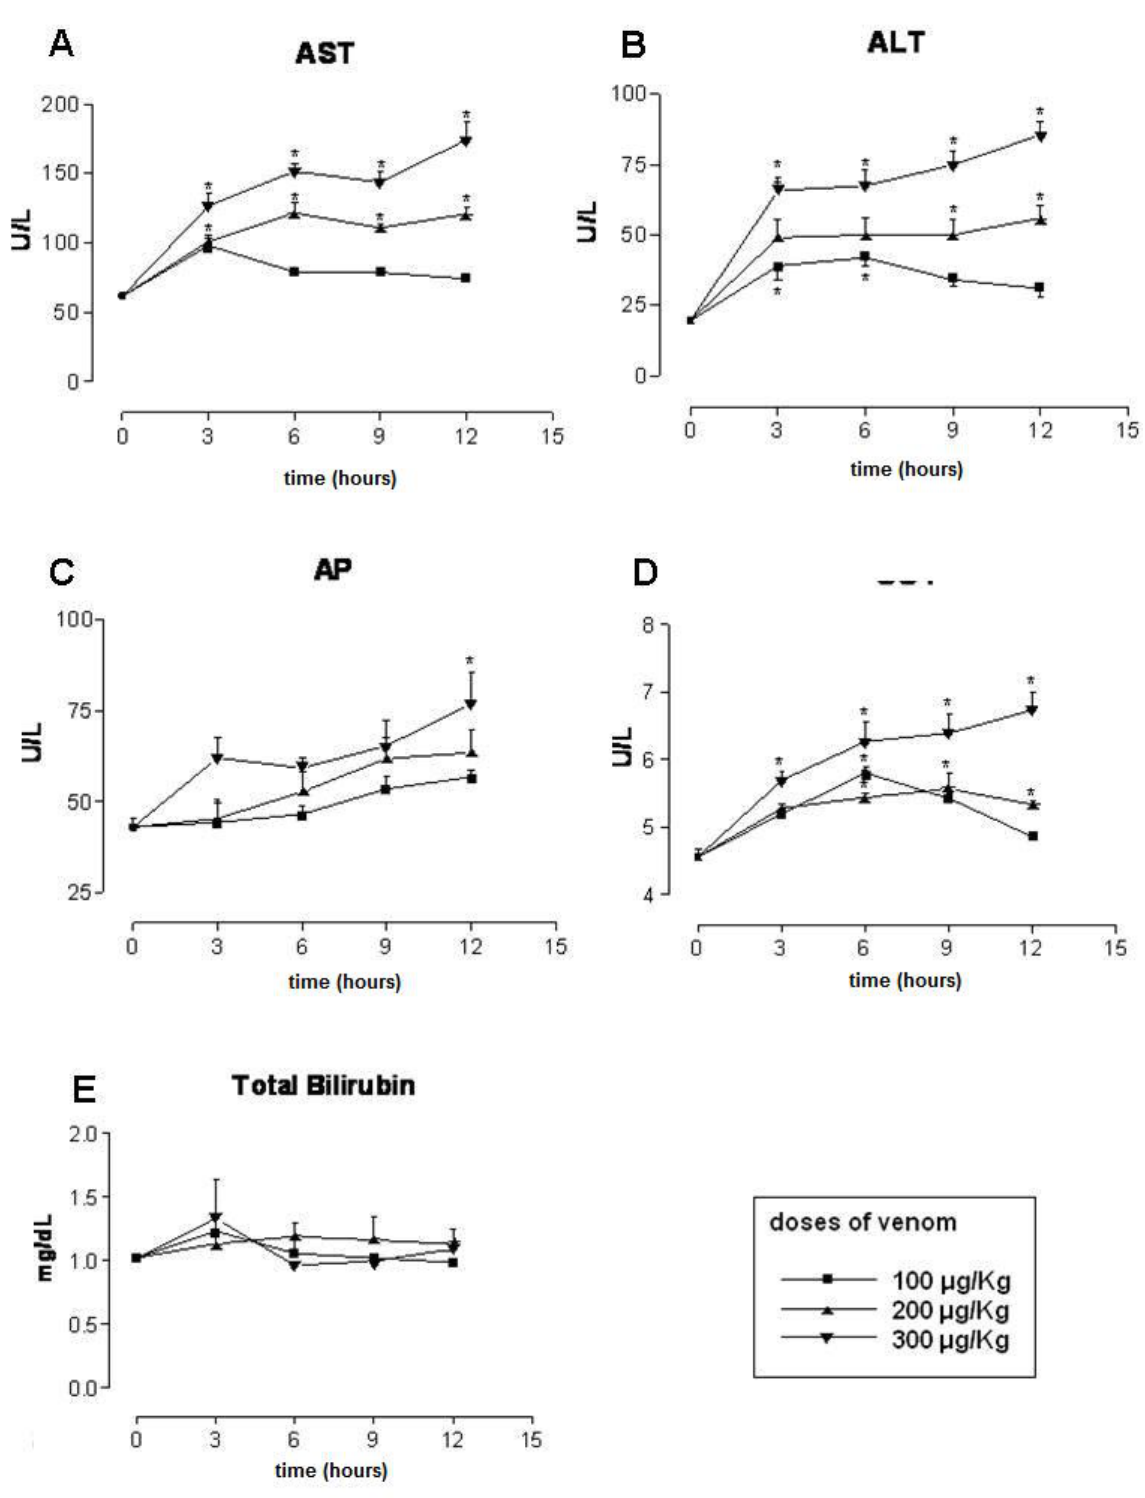
Figure 1 . Serum enzyme activities and bilirubin levels. Enzymes were collected from rat sera 3, 6, 9 and 12 hours after administration of 100, 200 and 300 μ g/kg of Cdt venom. ( A ) Alanine aminotransferase (ALT); ( B ) aspartate aminotransferase (AST); ( C ) alkaline phosphatase (AP); ( D ) gamma glutamyl transferase (GGT) and ( E ) total bilirubin concentration. Data expressed as mean values ± S.E.M for 7 rats per group; *p < 0.05 when compared to the control group and analyzed by one-way Anova, followed by Tukey-Kramer multiple comparisons